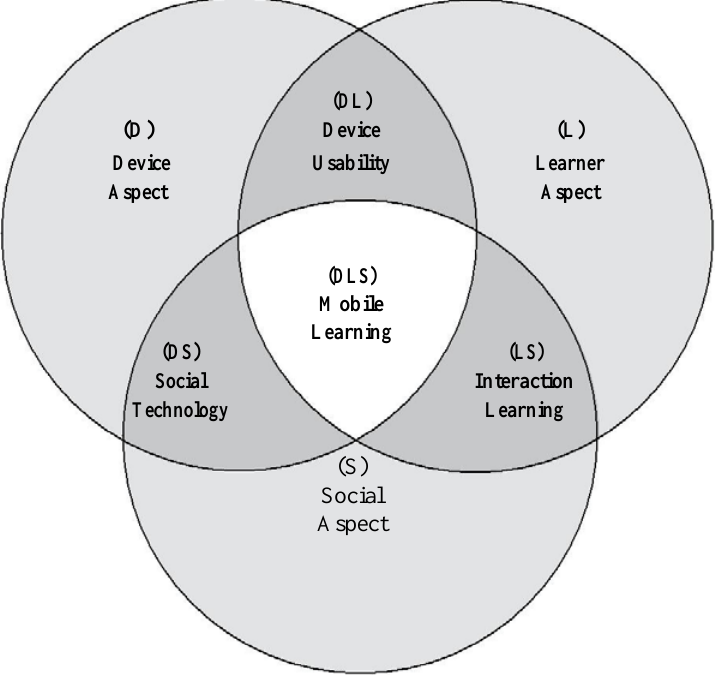
Fig. 1. The structure of FRAME